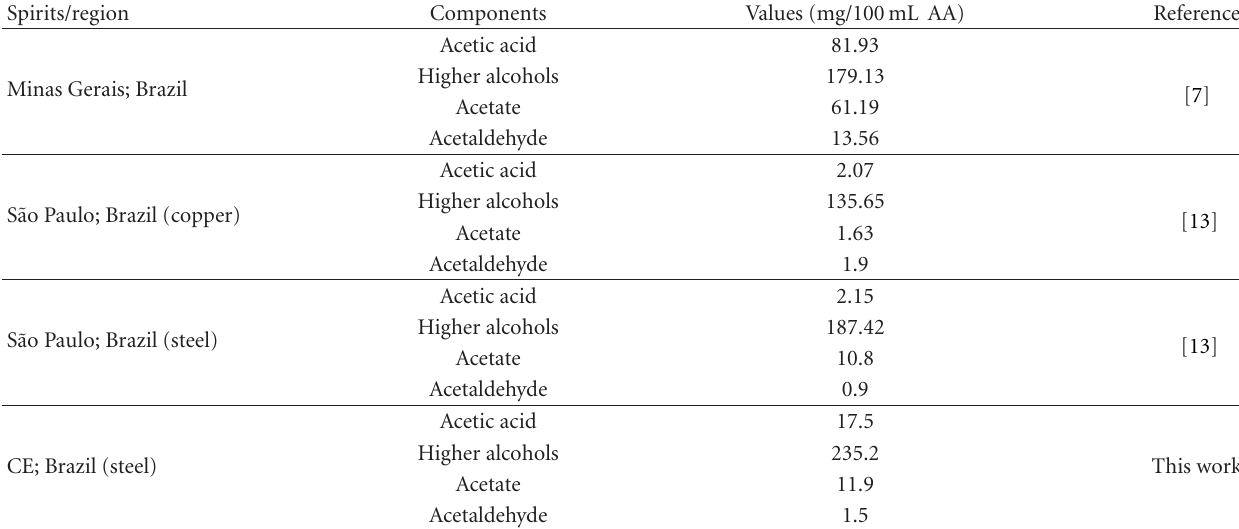
Table 3: Values of the volatile components found in di ff erent Brazilian spirits.